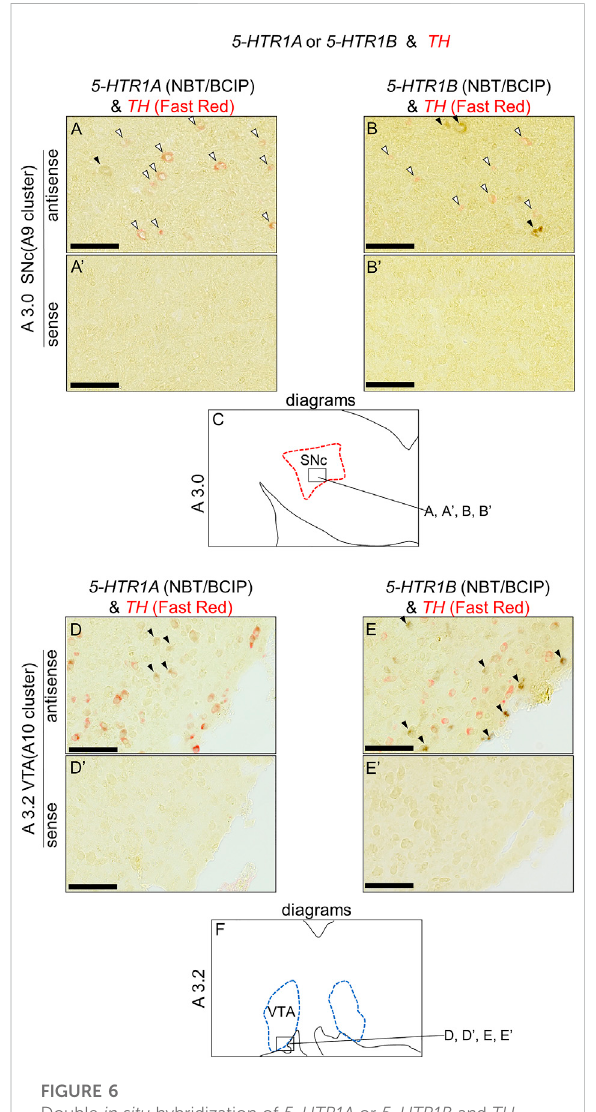
FIGURE 6 Double in situ hybridization of 5-HTR1A or 5-HTR1B and TH inthe SNc andVTA of theP1 chick brainstem.Digoxigenin-labeled ( 5-HTR1A and 5-HTR1B ) and fl uorescein-labeled TH RNA antisense (A,B,D,E) and sense (A 9 ,B 9 ,D 9 ,E 9 ) probes were used for double in situ hybridization in coronal sections of P1 chick brainstems. (A,B) and (A 9 ,B 9 ) Magni fi ed views of dopaminergic nuclei in the box in (C) . Black arrowheads indicate 5-HTR1A or 5- HTR1B signals, whereas white arrowheads indicate TH signals. (C) Diagrams of coronal sections shown in the A3.0 sections (Supplementary Figure S4). (D,E) and (D 9 ,E 9 ) Magni fi ed views of dopaminergicnucleiintheboxin (F) .Blackarrowheadsindicate 5- HTR1A or 5-HTR1B signals, whereas white arrowheads indicate TH signals. (F) Diagrams of coronal sections shown in the A3.2sections(SupplementaryFigureS4).SNc,substantianigrapars compacta; VTA, ventral tegmental area. Scale bars = 100 µm.